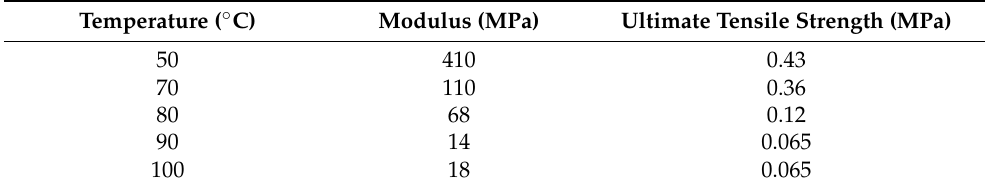
Figure 4. ( a ) DMA profile of PDEF as a function of temperature at five different frequencies, including 0.1 Hz, 0.5 Hz, 1 Hz, 2 Hz, and 5 Hz. ( b ) Stress–strain curve of PDEF at various temperatures indicated in the inset. Table 3. Engineering modulus and ultimate tensile strength of PDEF obtained from tensile test presented in Figure 3b.